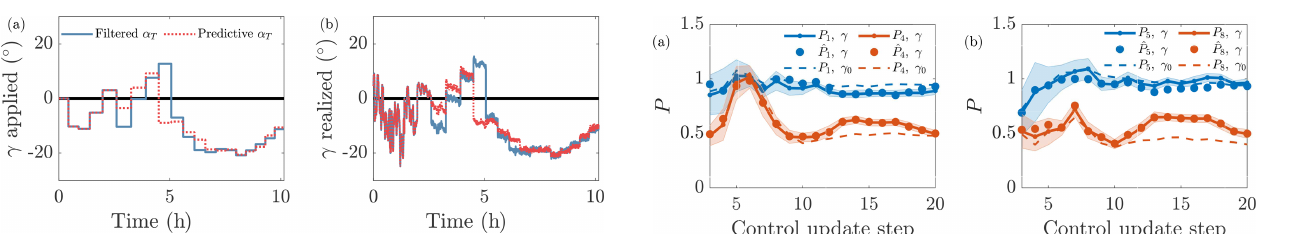
Figure 8. Power production results from the closed-loop control Case D and baseline yaw-aligned control cases. The LES power data are given by P , and the wake model estimates are given by ˆ P . The subscripts on the power denote the turbine number. The yaw- misaligned and yaw-aligned cases are denoted by γ and γ 0 , respec-